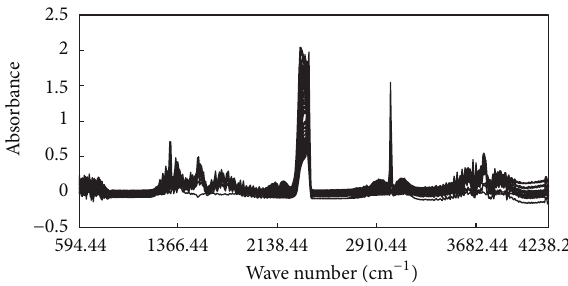
Figure 1: Original spectra data of fuel